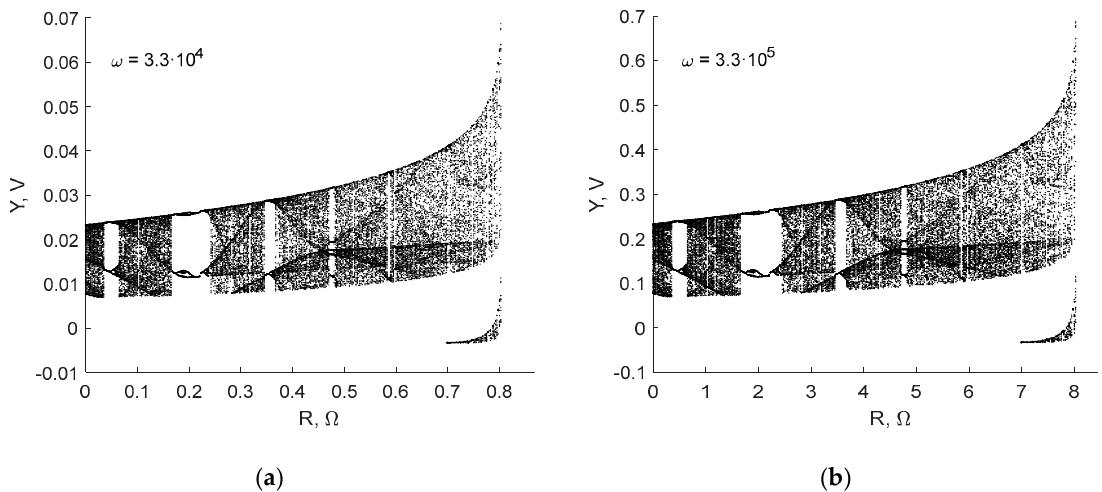
Figure 7. Bifurcation diagrams of the Sprott Case N system for di ff erent values of ω Figure 7 . Bifurcation diagrams of the Sprott Case N system for different values of ω .